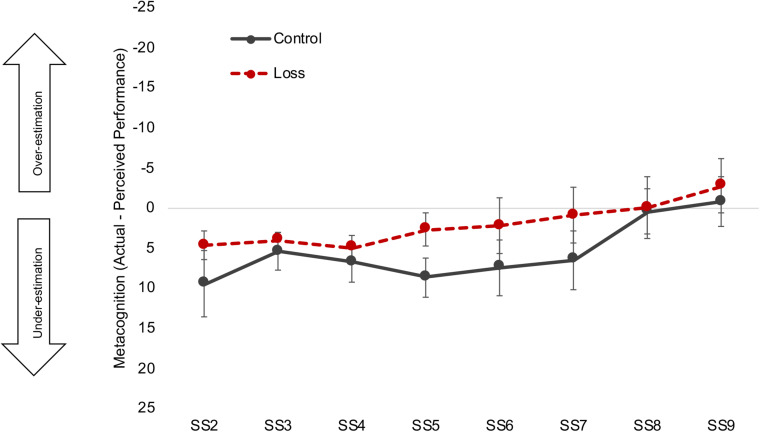
Absolute metacognitive accuracy. Black solid line and red dashed line denote control and loss condition, respectively. Error bars represent 95% confidence intervals. Participants in the loss incentive condition had less discrepancy between their perceived and actual performance than did participants in the control condition, with group differences largest at the intermediate set sizes (see text and Supplementary Table S6 for statistical details). Note: Scale on y-axis is reversed for ease of interpretation. Zero means accurate judgment. See Supplementary Material S7 for the full age × incentive graph. SS, set size.